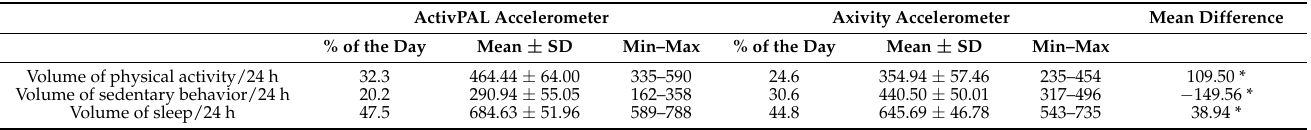
Table 1. Descriptive statistics of 24-hour movement behaviors measured by the ActivPAL and Axivity accelerometers for the total sample ( n = 16 participants).